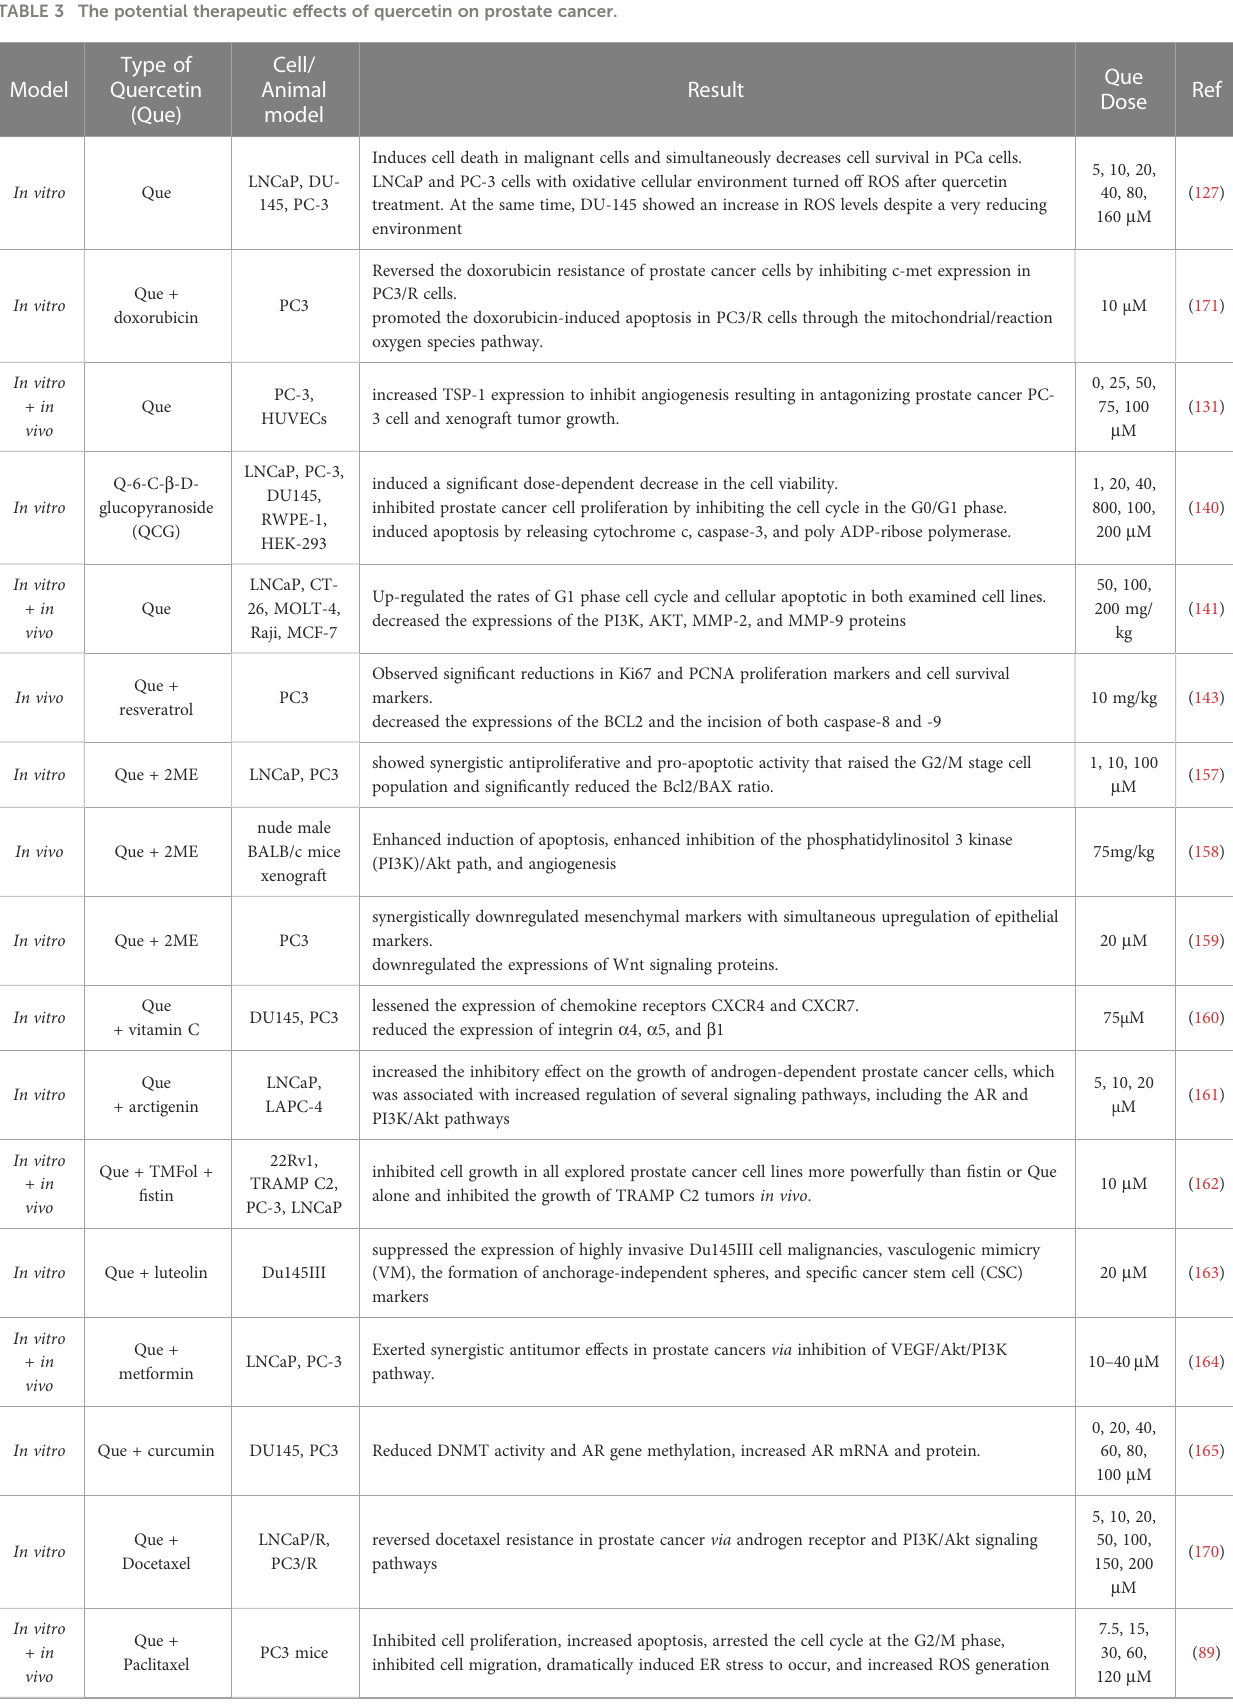
TABLE 3 The potential therapeutic effects of quercetin on prostate